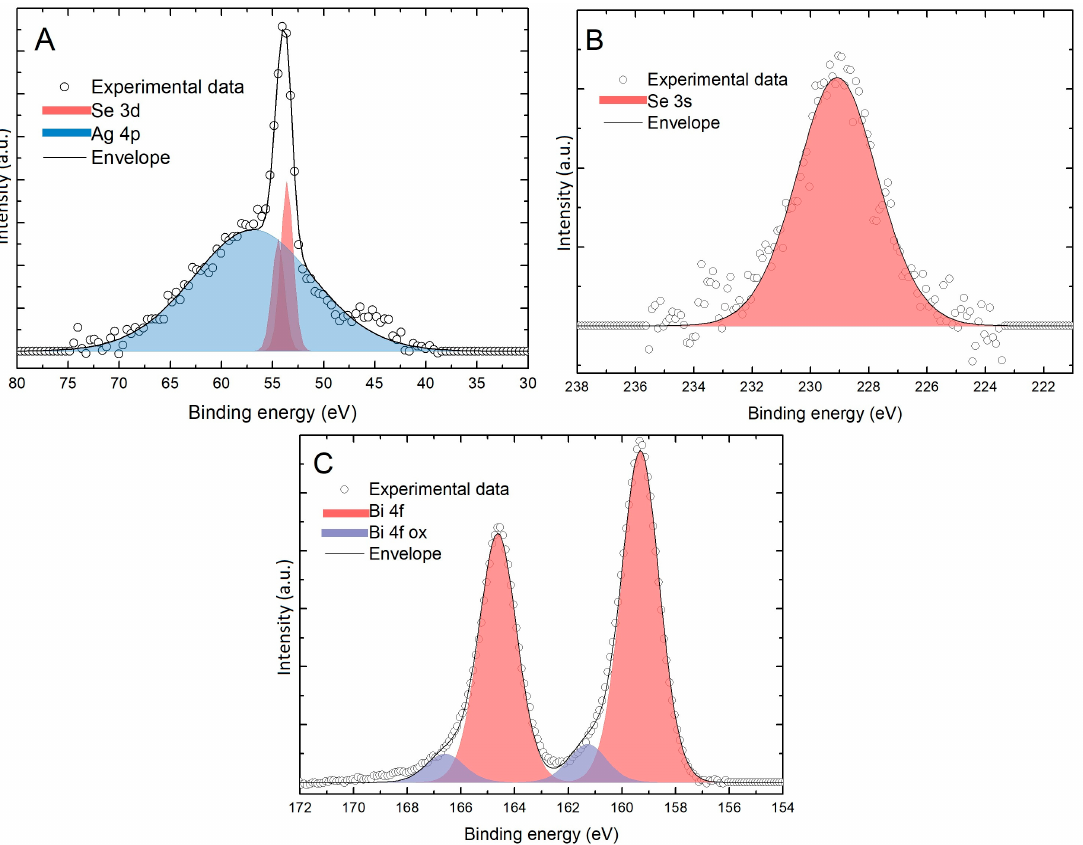
Figure 5. ( A ) Stripped charge, from samples with up to 10 layers, before of the Bi (black) and then of the Se (red); ( B ) ratio between the quantity of Se and the Bi (ideal 1.5).